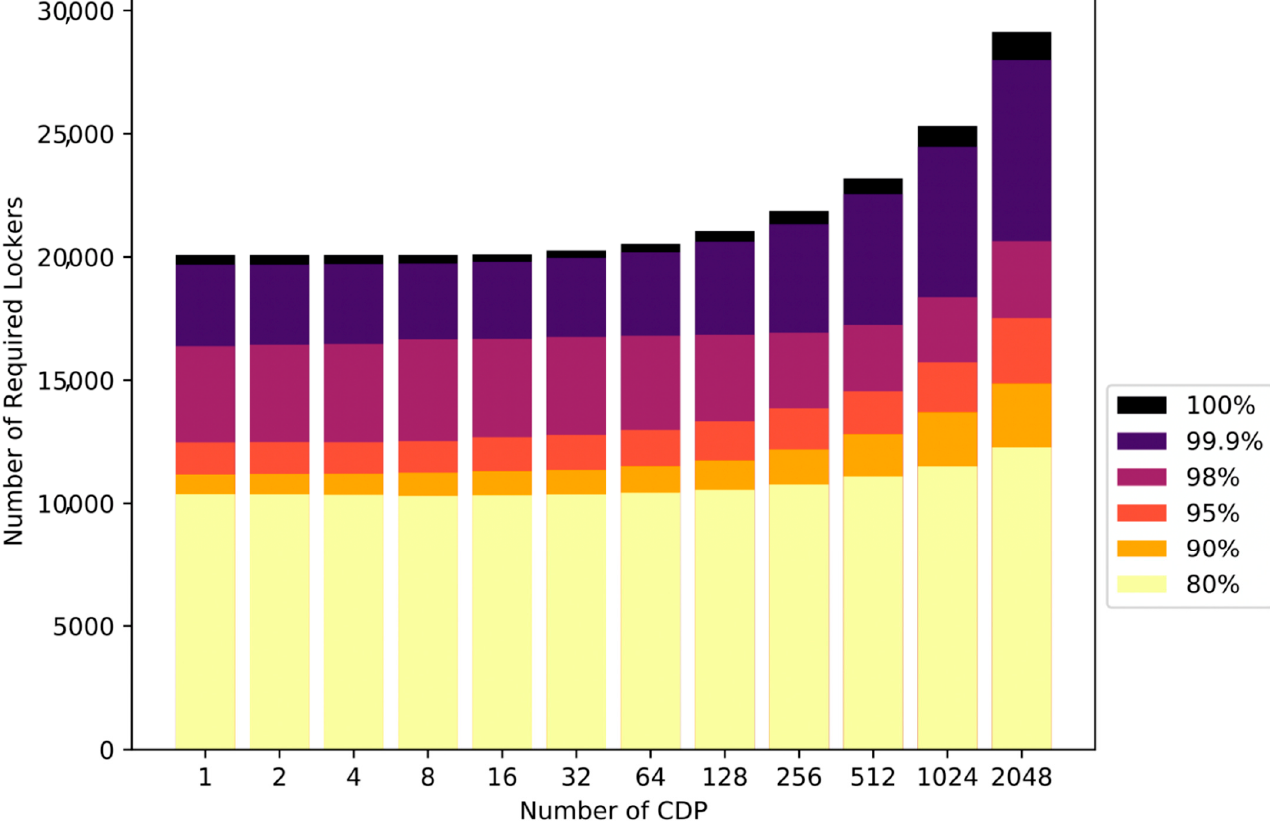
Figure 7. Number of lockers required (Density 1.0).